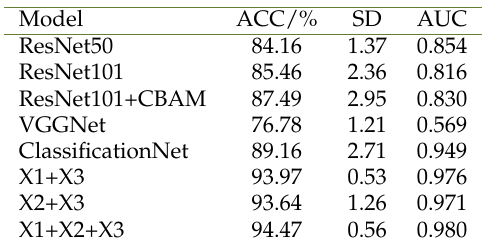
Table 2. Comparison of accuracy of different